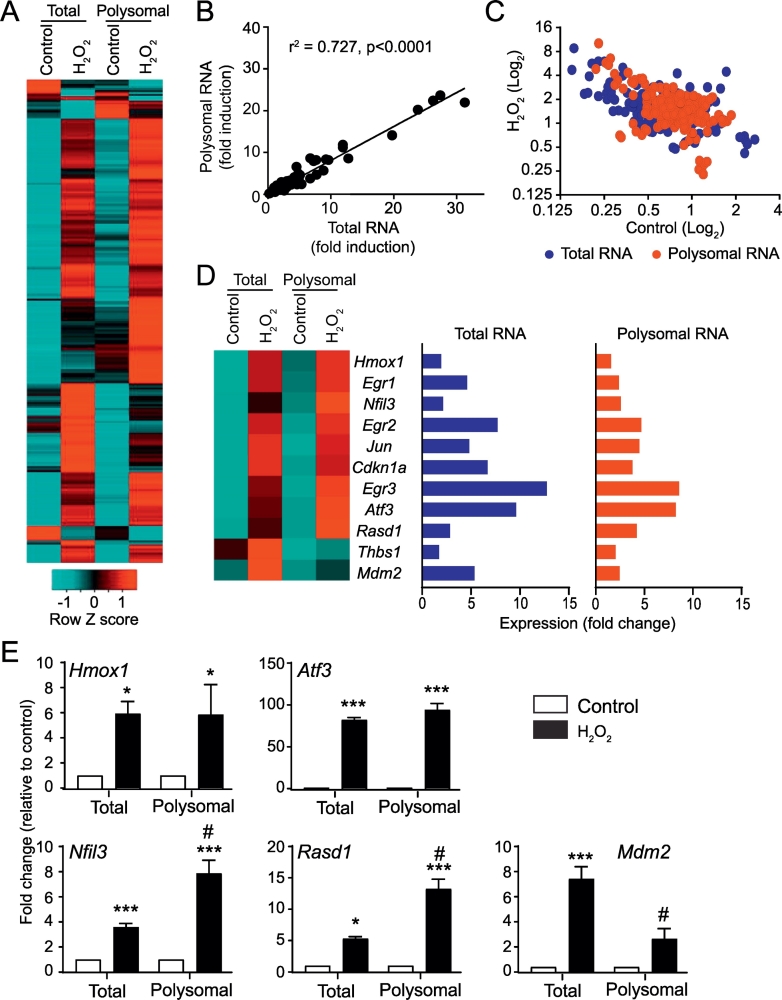
Recruitment of mRNAs induced by H2O2 to polysomes for translation. Cardiomyocytes were unstimulated (Control) or exposed to 0.2 mM H2O2 (1 h) and total or polysomal RNA prepared for microarray analysis [(A) - (D)] or qPCR (E). (A) Heatmap (Log2 scale) of all probesets with significantly decreased or increased expression (>1.5-Fold change; FDR < 0.05) in total or polysomal RNA fractions. Expression values were normalised to the gene median. (B) Relative fold change of upregulated mRNAs in polysomal vs total RNA pools. Linear regression analysis indicates that most mRNAs are regulated similarly in total and polysomal fractions and are translated efficiently. (C) Overlay plot of mRNAs induced by H2O2 in total and polysomal RNA pools to show differential changes in some genes. (D) Heatmap (Log2 scale) of specific genes relevant to this study is shown on the left, with fold change relative to controls on the right. (E) qPCR validation of microarray data showing similar changes in expression in total or polysomal RNA fractions for Hmox1 and Atf3, enhanced recruitment of Nfil3 and Rasd1 to polysomes for translation and less efficient recruitment of Mdm2 to polysomes. Results are means ± SEM (n = 4 independent myocyte preparations; these are different preparations from those used for microarray analysis). *p < .05, ***p < .001 relative to unstimulated controls, # p < .05 relative to fold-change in total RNA pool (one-way ANOVA with Tukey post-test).